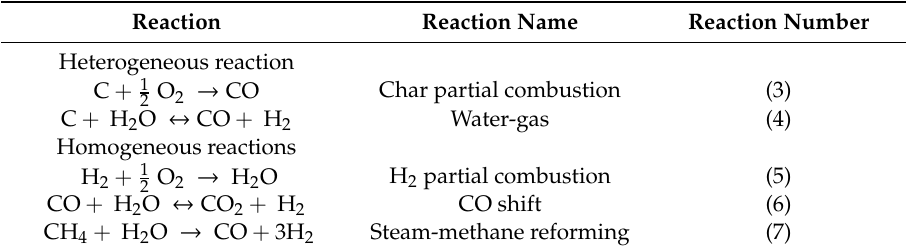
Table 3. Gasification reactions